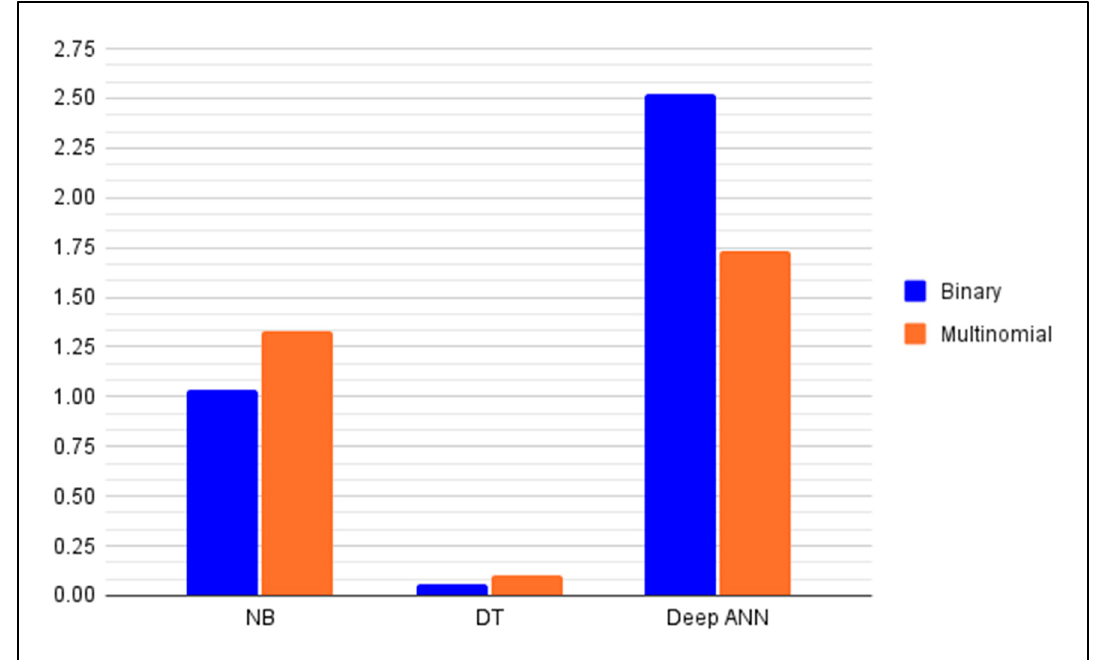
Figure 10. Anomaly detectors’ memory size (kB).